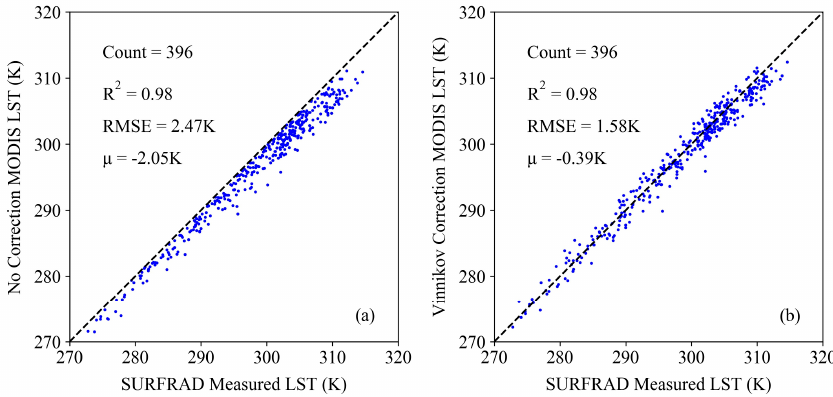
Figure 8. Comparison of the SURFRAD-measured LST and the MODIS LST before angular correction ( a ) and after correction ( b ).